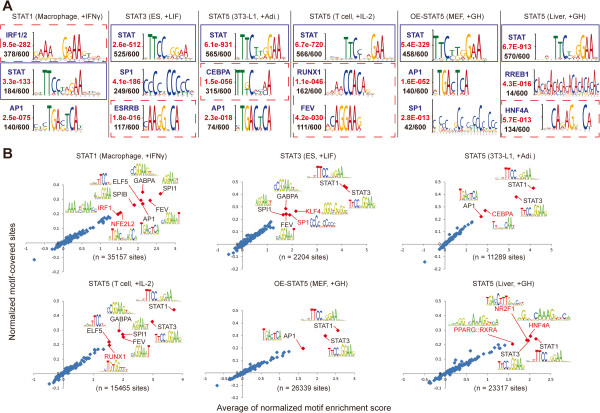
Cell specificity of transcription factor binding motifs associated with STATs. (A) Distinct sets of specific TFBSs were identified in six representative cell types (Figure 2) within +/− 75 bp of the STAT binding peak centers using the MEME-ChIP de novo motif identification program [35]. Top three motifs are shown. The statistical significance of the motifs was estimated using E-value (red) and motif occurrence (black) as described previously [35]. The blue and red dashed boxes indicate the identified GAS motifs and cell-type specific TF binding motifs, respectively. (B) All motif occurrences on the intermediate-confidence STAT binding sites (+/− 75 bp of the peak center) were calculated using the MOODS algorithm with 130 position-frequency matrices available on the JASPAR website (p value <  0.001). The x-axis and y-axis indicate the mean average of normalized motif enrichment scores and motif-covered sites, respectively. Each dot represents a single TFBS and red dots show significantly associated co-TFs (normalized proportion > 0.2 and average of normalized motif enrichment score > 1.5). Red letters indicate TFBSs unique to the given cell-type.